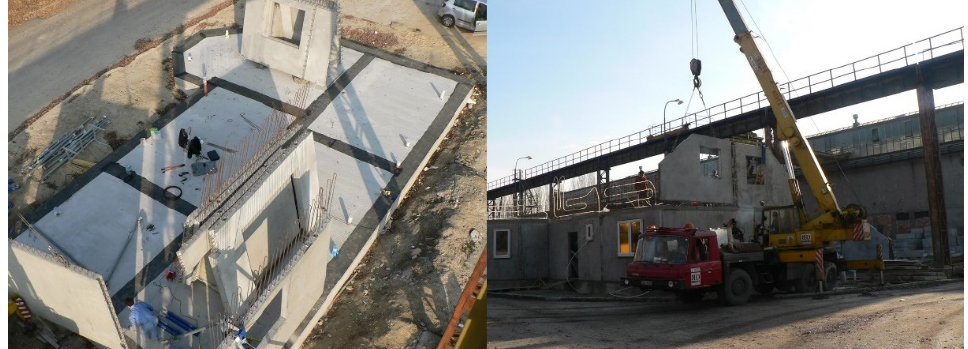
Figure 18. Construction with upgraded panels [1].